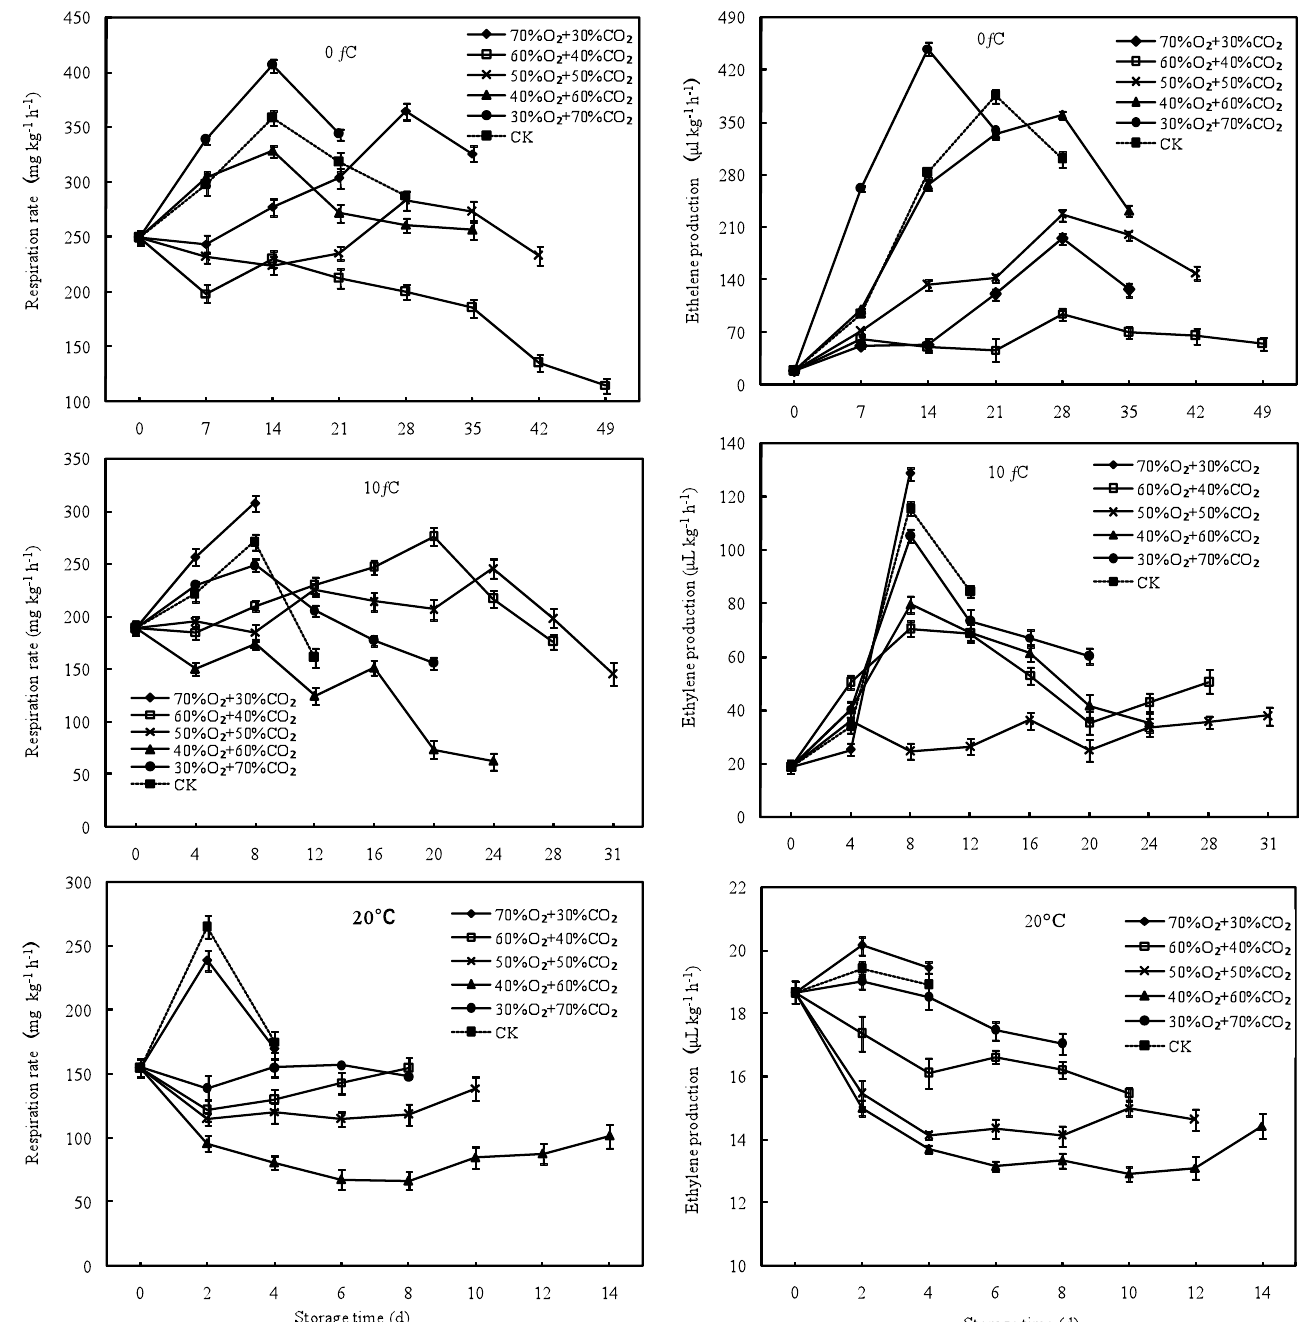
Fig. 1: Respiration rate of broccoli heads treated with varying O 2 /CO 2 levels at different temperature. Vertical bars indicate the standard deviations for each treatment (n=5). Air treatment was used as control.